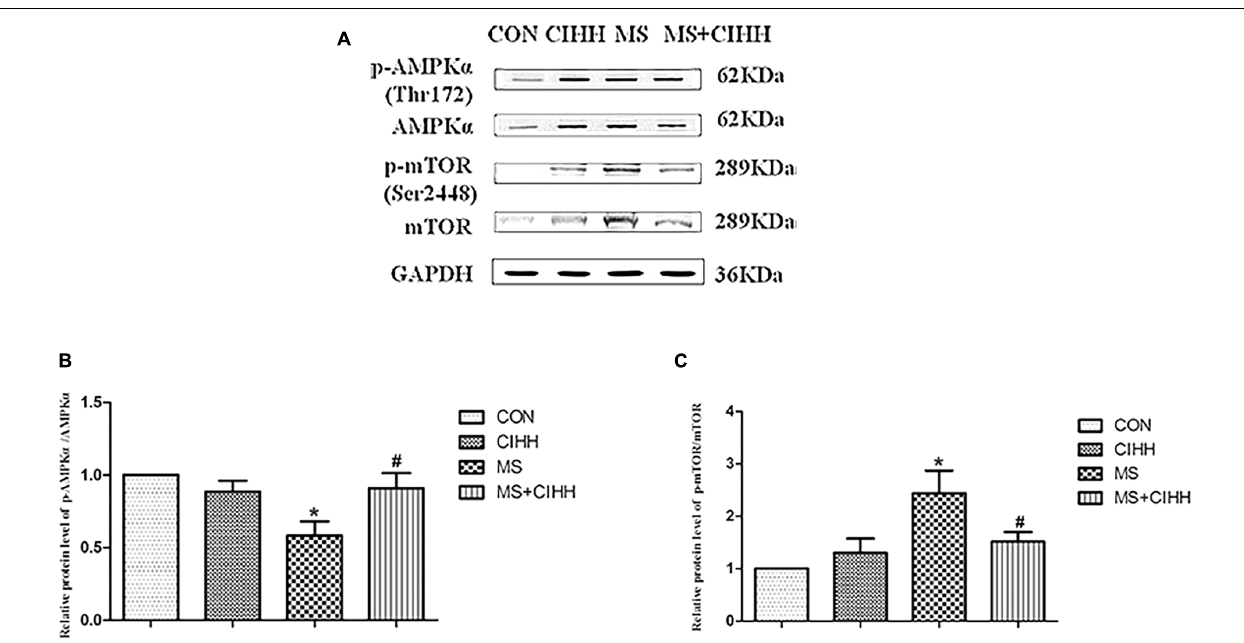
MS + CIHH rats ( P < 0.05, Figure 7